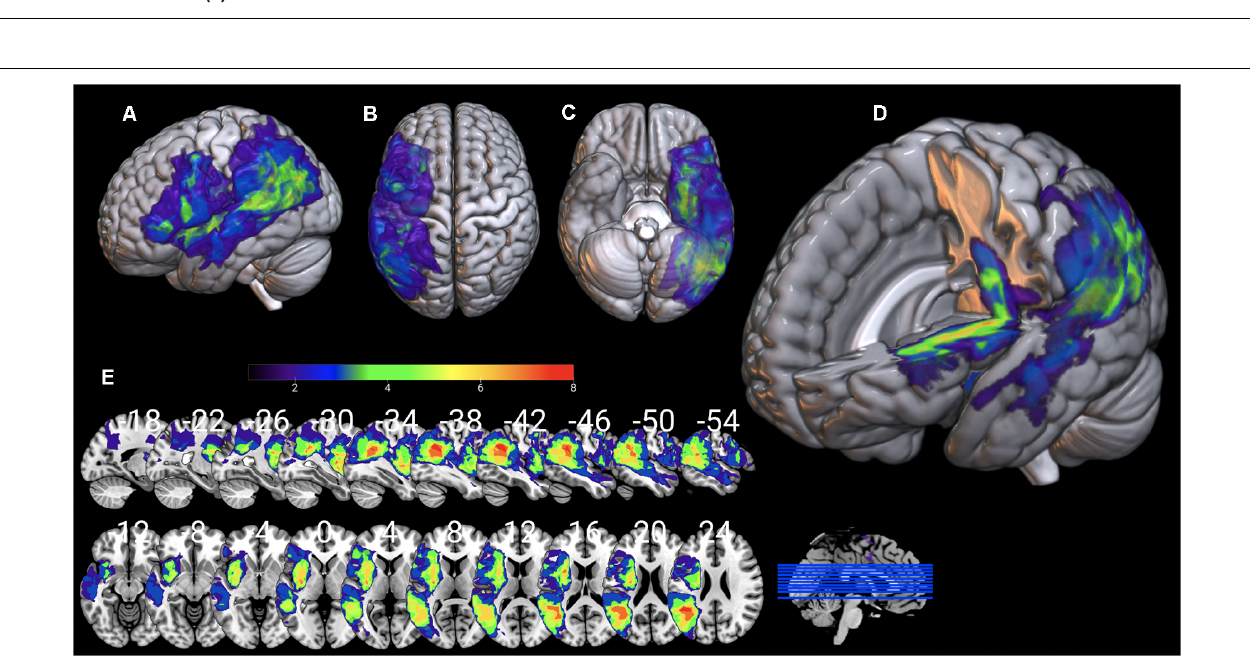
FIGURE 7 | Lesion maps overlay for the AG1 group are shown on 3D views of the standard average brain. The left hemisphere (A) and the dorsal (B) and orbital (C) views of the brain are presented. In (D) part of the left hemisphere is removed. The sagittal and axial serial sections displaying the lesions in MNI stereotaxic coordinates are shown in (E) .